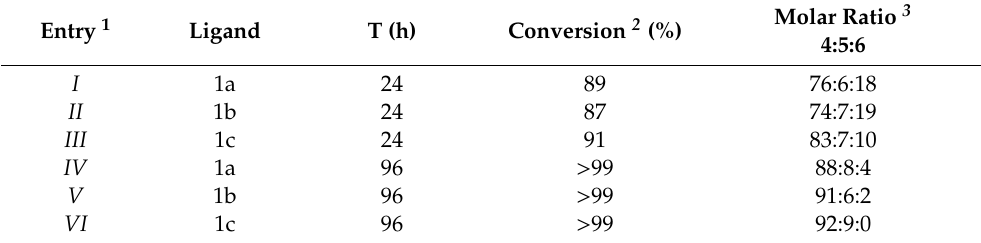
Table 2. Results of the catalytic allylic alkylation of cinnamyl acetate with sodium diethyl-2- methylmalonate using a mixture of [Pd( η 3 -C 3 H 5 )( µ -Cl)] 2 and the corresponding ligand.